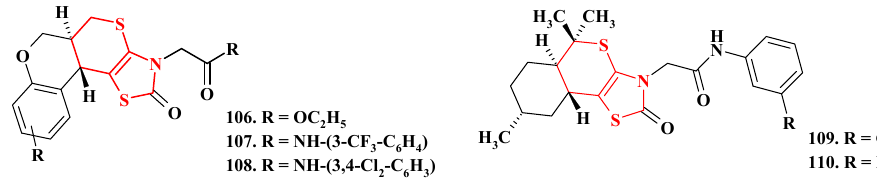
Figure 6. Chromeno[4 ′ ,3 ′ :4,5]thiopyrano[2,3- d ]thiazoles and isothiochromeno[3,4- d ]thiazoles with anticancer activity in